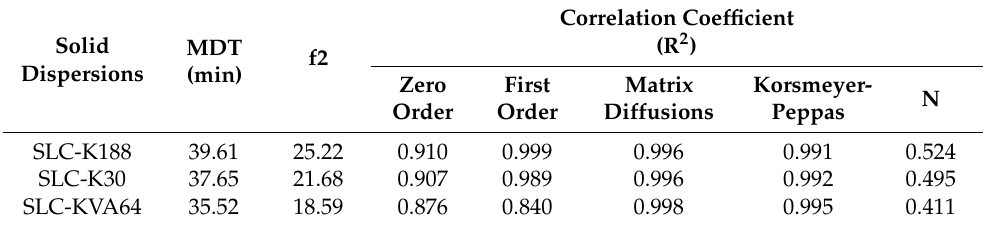
Table 1. Similarity factors and release kinetics of prepared SDs.